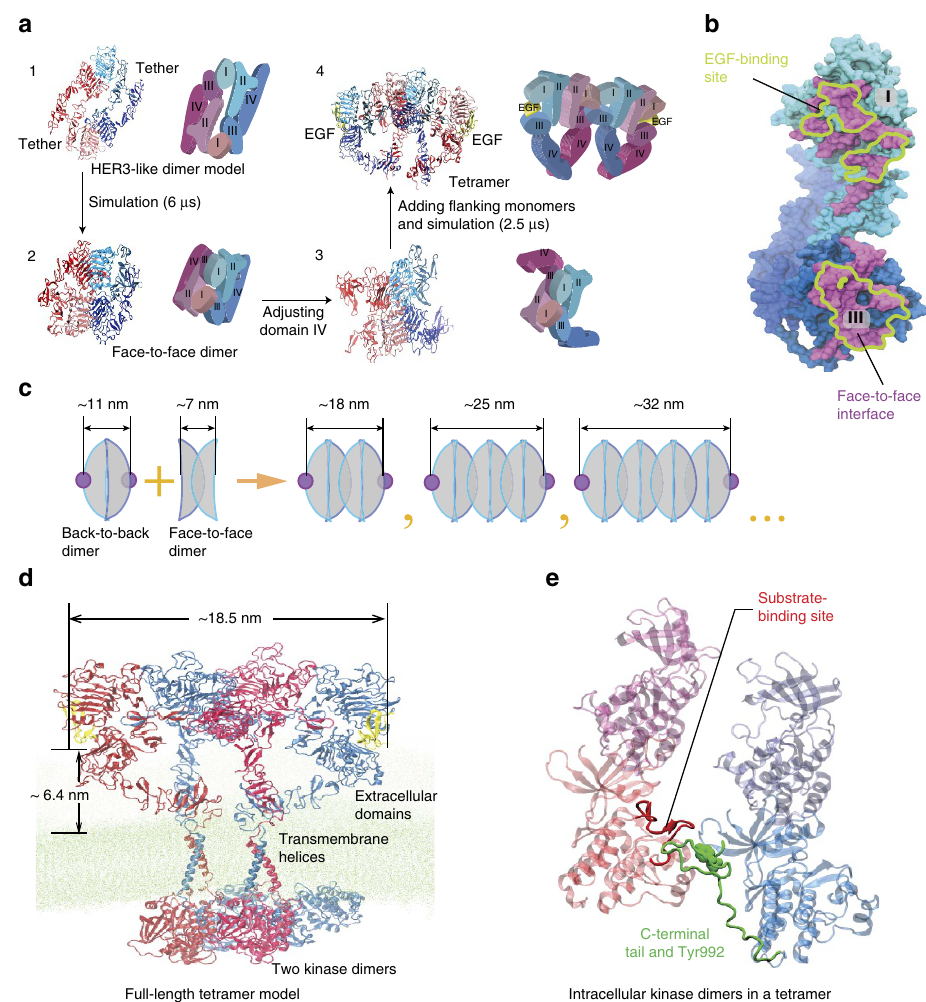
Figure 2 | The structural model of EGFR tetramers. ( a ) Key steps in constructing the model of a ligand-bound EGFR tetramer: (1) an initial EGFR dimer model generated using a crystal structure of a HER3 dimer as a template; (2) a face-to-face dimer produced by simulation of the initial dimer model, in which the interaction interface remained unchanged but domains I–III in each monomer departed from the tethered conformation for the conformation seen in the active dimer; (3) domains IV are manually modelled to mimic the conformation of monomers in an active dimer; and (4) a tetramer model constructed by adding two-ligand-bound monomers in back-to-back interactions with the previous dimer. In addition to the ribbons generated using atomic coordinates, cartoon figures are used to illustrate the modeling procedure. ( b ) The site for the face-to-face interaction (purple) and the outline of the largely overlapping EGF binding site at domains I and III. ( c ) A diagram illustrating the open-ended oligomerization scheme for EGFR extracellular domains based on repeating the back-to-back and the face-to-face interactions. ( d ) The full-length structural model of an EGFR tetramer as a dimer of active dimers assembled by the face-to-face interactions. The predicted separation between the N-termini of the two EGF ligands and the average EGF-membrane distance are marked. The coordinates of the model are available in Supplementary Data. ( e ) The arrangement of the two intracellular active kinase dimers in the tetramer model, by which the phosphorylation site Tyr992 (green) of one receptor is positioned in the proximity of the active site (red) of a kinase domain from the neighbouring separation at 19.9 ( (cid:2) 2.9/ þ 3.7) nm suggested by the FLImP